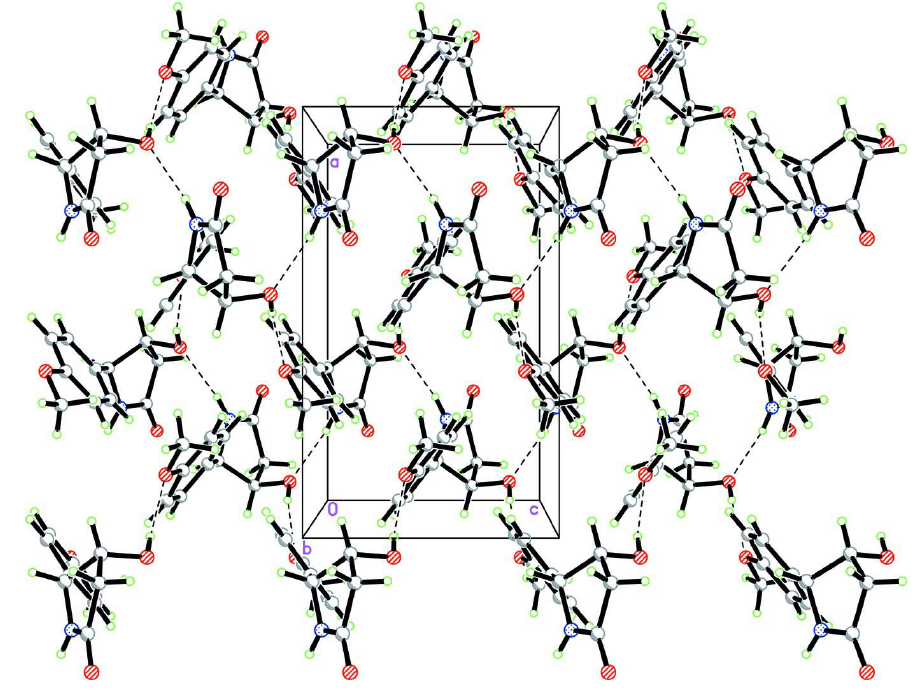
Figure 2 The crystal packing of (I), viewed along the b axis. Hydrogen bonds were drawn as dashed